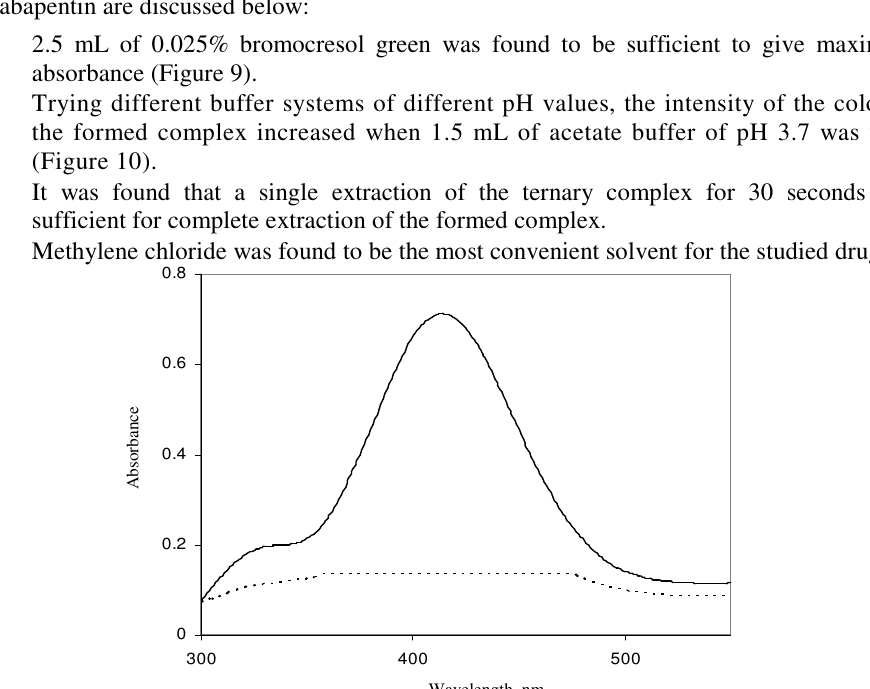
Figure 8. Absorption spectra of the ion pair formed through reaction of 100 µ g mL -1 gabapentin with 0.025% bromocresol green blank solution